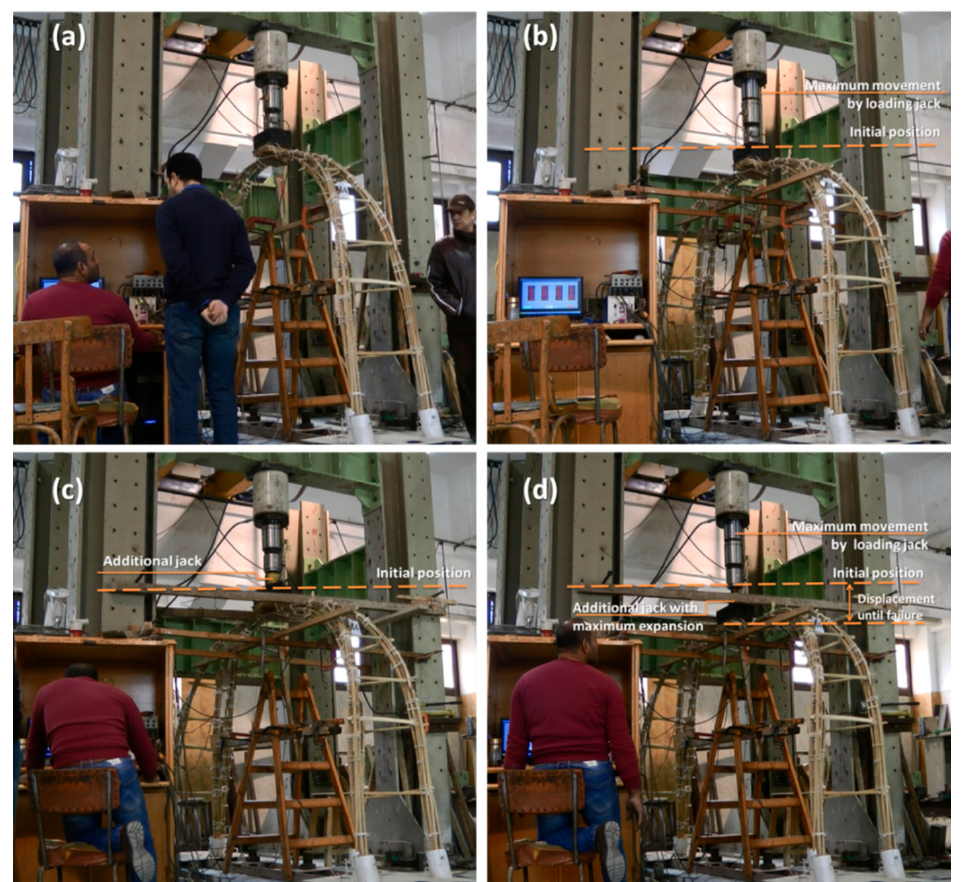
Figure 16. Experimentation of the first specimen. ( a ) Initial state before loading. ( b ) Reaching the maximum movement by loading jack for the 1st time: 250 mm. ( c ) Addition of the hydraulic jack after fixing the current height. ( d ) Specimen at failure.